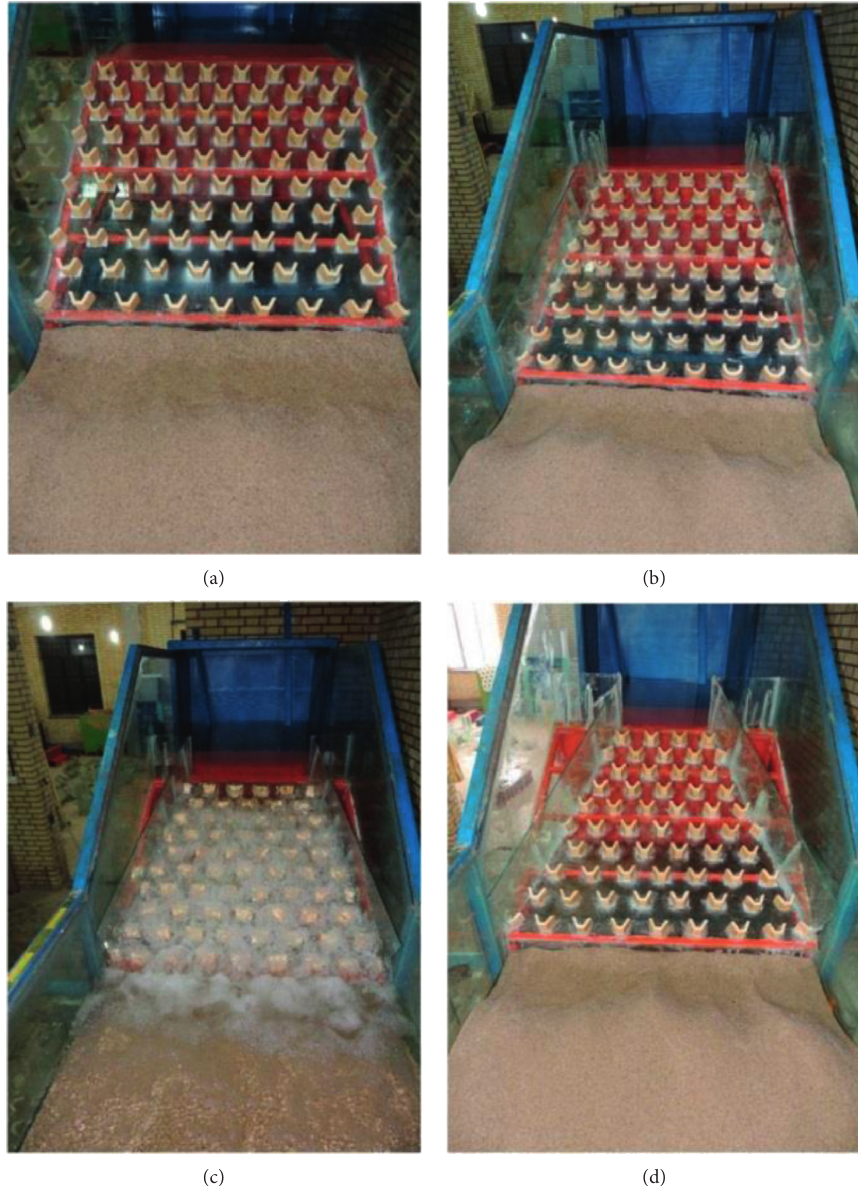
Figure 6: The baffled chute: (a) b 1/ b 2 � 1 with a trihedral block, (b) b 1/ b 2 � 1.45 with a semicircular block, (c) b 1/ b 2 � 1.75 with a USBR block, and (d) b 1/ b 2 � 2.45 with a trihedral